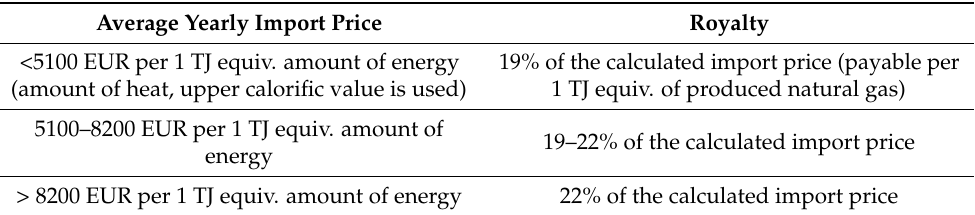
Table 5. Royalty for natural gas production in the Republic of Austria (sliding